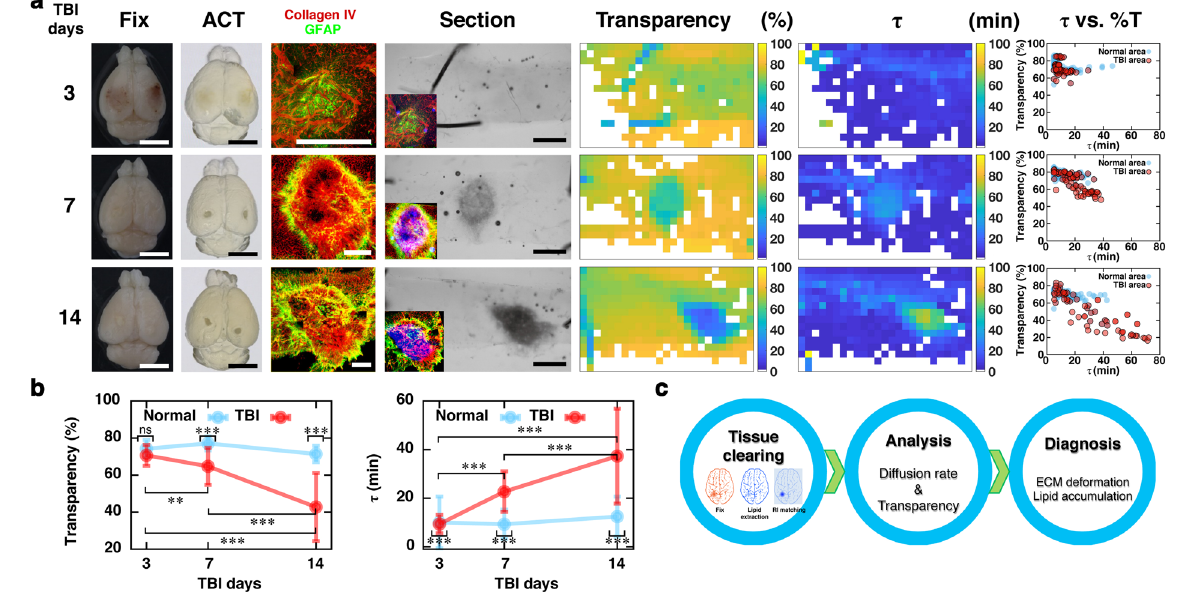
Figure 5. Diagnostic application of tissue clearing (a) Images of mouse brain 3, 7, and 14 days after cryogenic TBI. (From left to right) bright-field images of whole brain before (Fix) and after tissue clearing (ACT); section images of injured brain regions stained with collagen IV (red; ECM accumulation), GFAP (green; reactive astrogliosis); 1-mm-thick brain slice including both injured and normal regions; transparency and τ maps; and scatter plot of τ -transparency showing the optical condition of the tissues. Insets show the superimposed images of immunolabelings and optical contrast (pseudocolored with inversed blue). The sizes of scale bars in (a) are 5 mm for Fix and ACT, 400 μ m for immunostaining, and 1 mm for Section. (b) Transparency and τ profiles of normal and injured areas at 3, 7, and 14 days after TBI. Mean ± SD for tiles of normal area at TBI days 3, 7, 14 (N = 37, 71, 68 respectively) and injury area at TBI days 3, 7, 14 (N = 89, 54, 46 respectively). ** P < 0.01, *** P < 0.001 compared to control determined by one-way ANOVA with post-hoc Tukey (c) Proposed diagnostic process for deformed tissue, using tissue clearing and τ